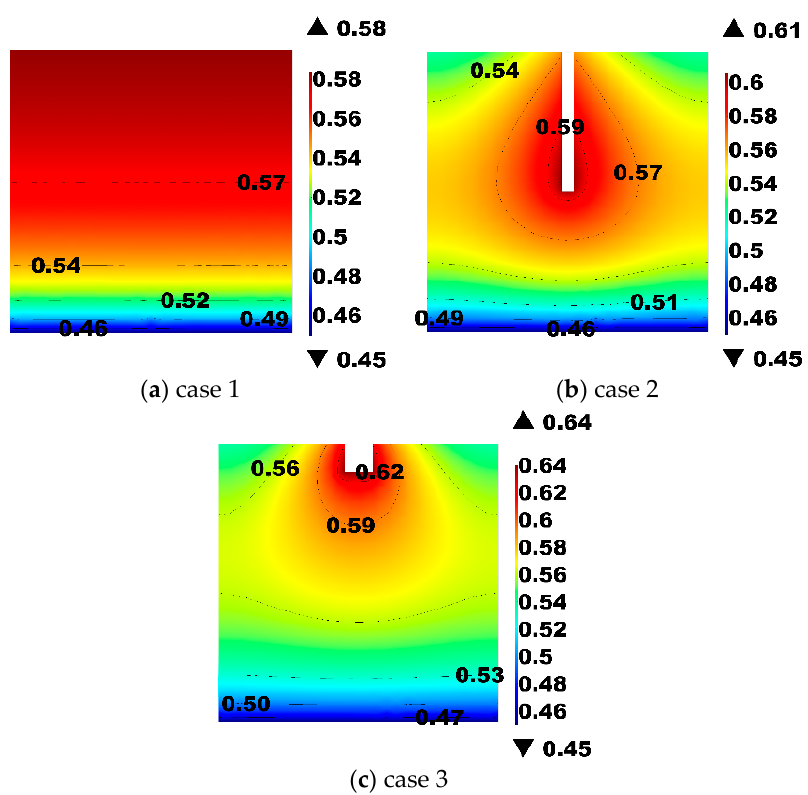
Figure 4. Saturation of MSW after 200 d of leachate recirculation.